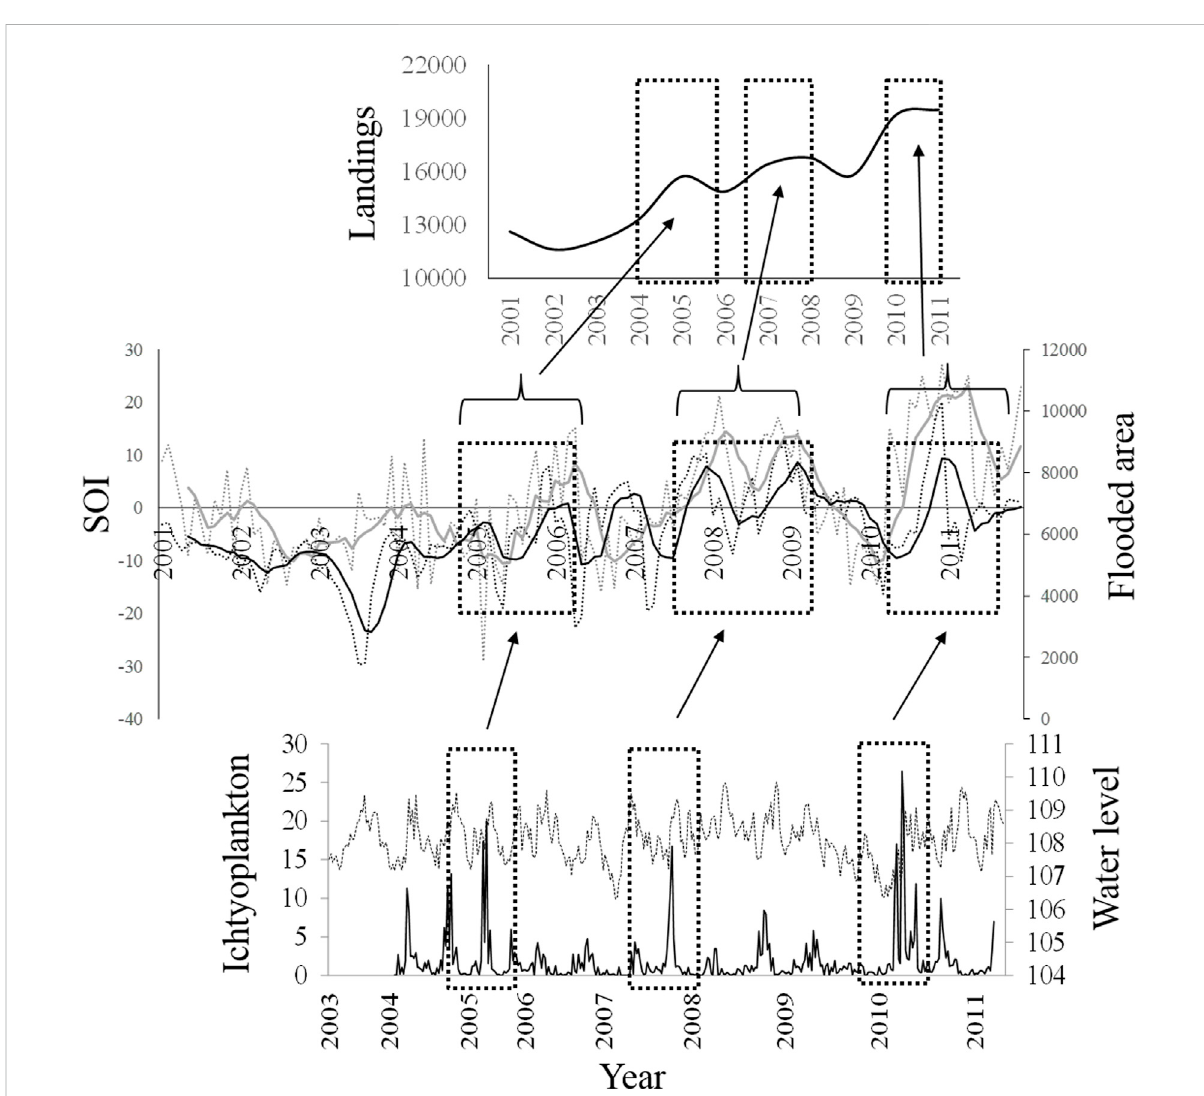
FIGURE 8 Relationship between (A) fi sheries landings between years 2000 and 2014, (B) SOI values and fl ooded area (SOI values: monthly-gray pointed line, moving average for fi ve periods- black pointed line; Floodplain area values: monthly-gray line, moving average for fi ve periods-black line),